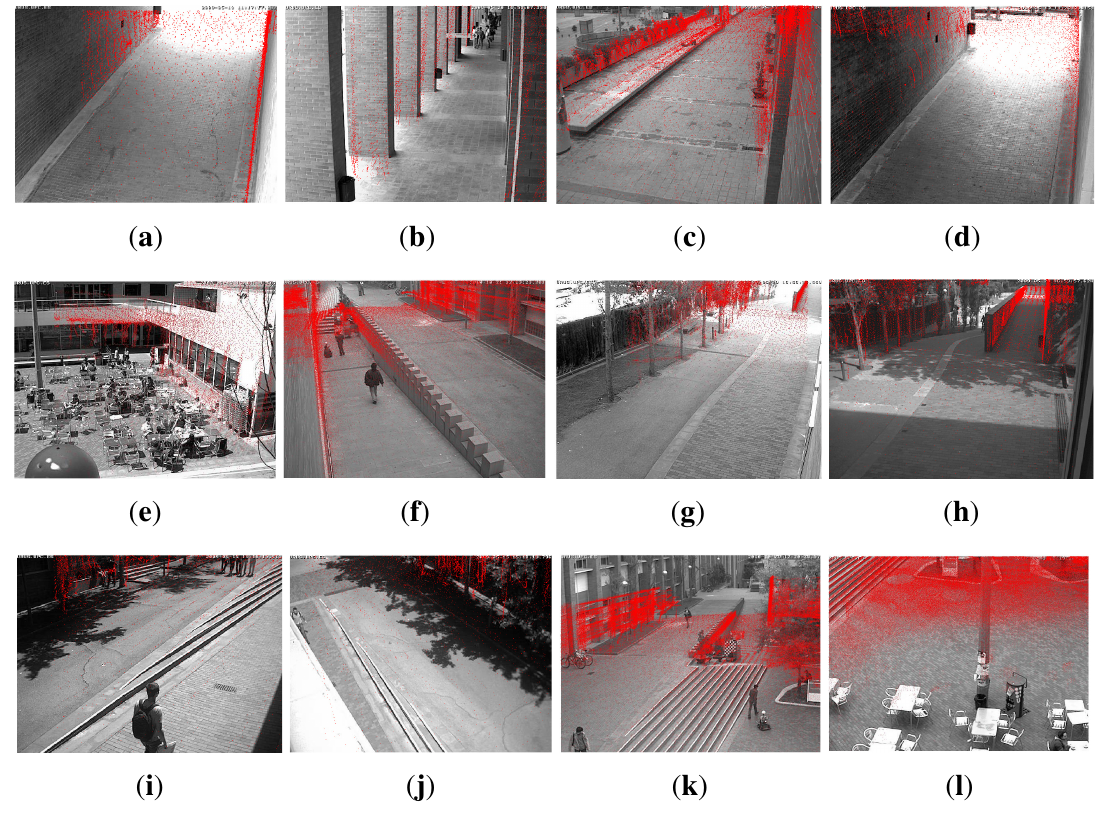
Figure 11. Visualization of range data on each of the camera views of the BRL